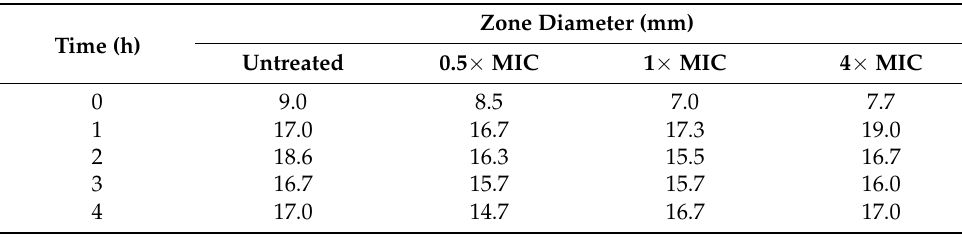
Table 2. Effects of rhodomyrtone on staphylococcal lipase activity, measured as zone diameter on MHA supplemented with 1%